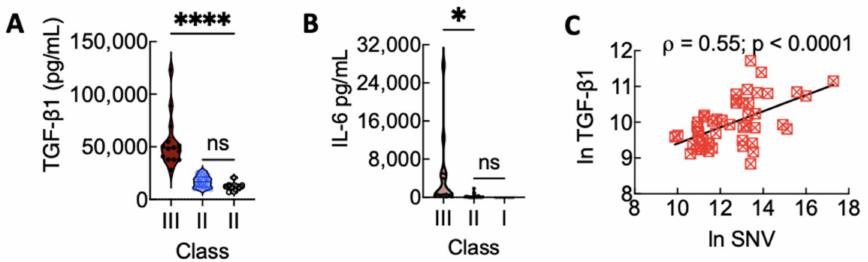
Figure 3. ( A ) Relative expression of TGF- β 1 in Class III, II, and I. ( B ) Relative expression of IL-6 in Class III, II, and I on all days. Levels of active TGF- β 1 and IL-6 were compared by ordinary one-way ANOVA; **** p < 0.0001, * p < 0.05. ( C ) The association between TGF- β 1 and SNV during HCPS assessed by Pearson’s correlation test showing a positive correlation between the variables. The figure was produced in GraphPad Prism version